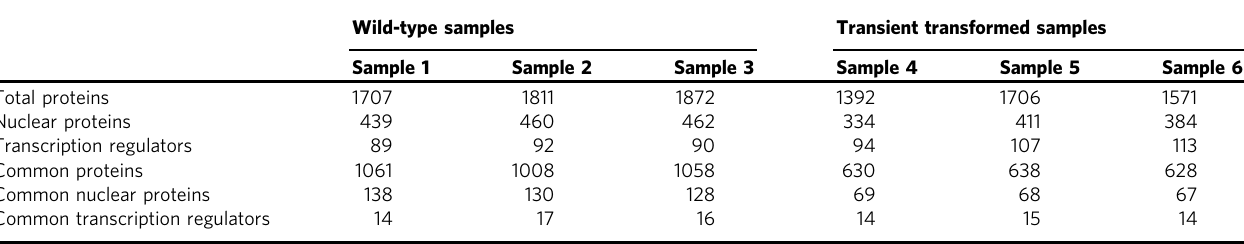
Table. 1 Identi fi cation of the DNA associated proteins using R-ChIP.